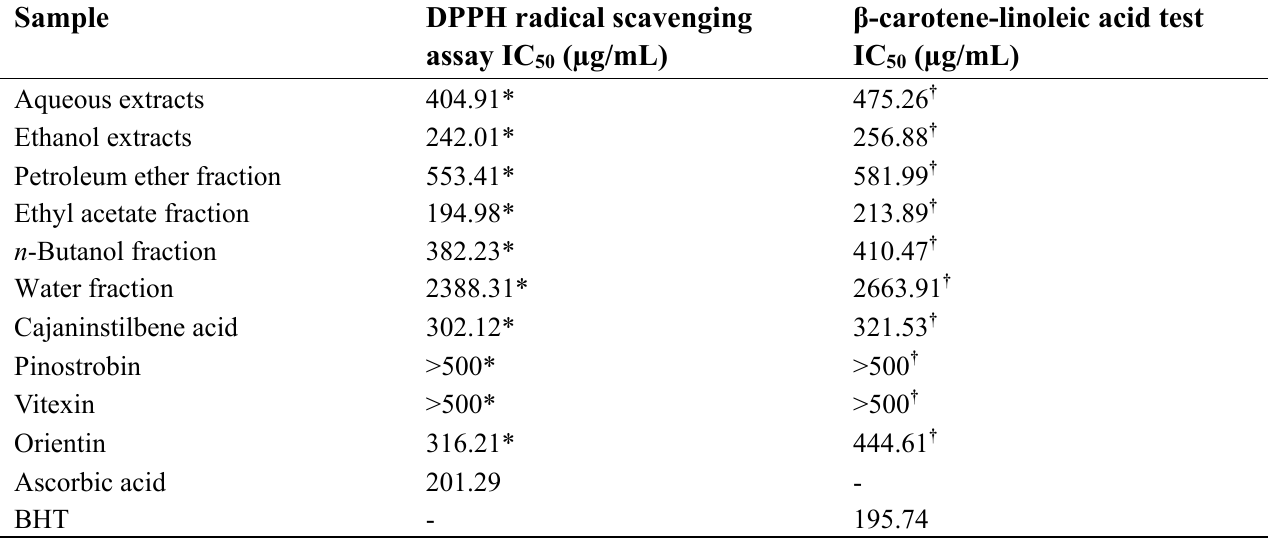
values of extracts, four fractions and main components of pigeonpea Table 2. IC 50